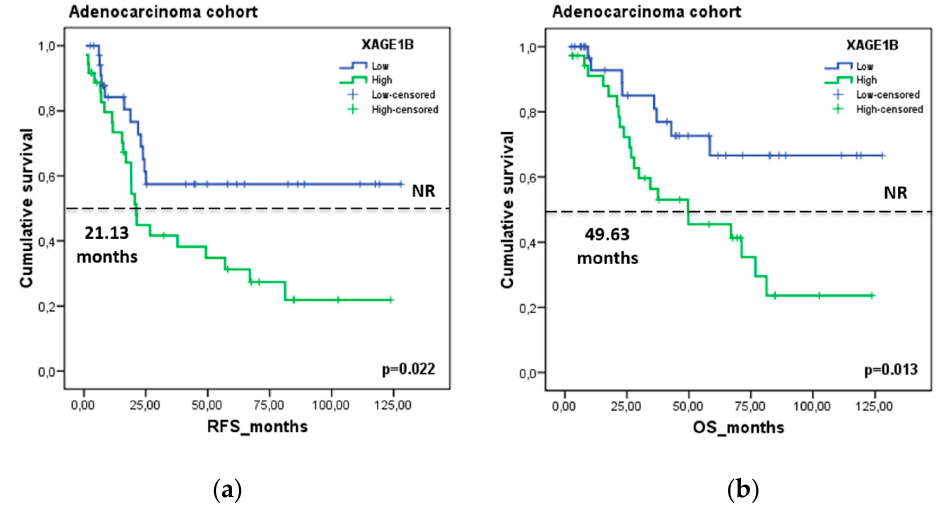
Figure 10. Prognostic value of XAGE1B in the HGUV NSCLC cohort. Kaplan–Meier plot for ( a ) RFS and ( b ) OS according to gene expression relative to reference genes ( ACTB, GUSB, CDKN2A ) in the LUAD group. Blue lines represent patients with higher levels of XAGE1B expression, whereas green lines represent patients with lower expression levels. Cutoff values correspond to the median relative expression. p -values were calculated using the Kaplan–Meier test.